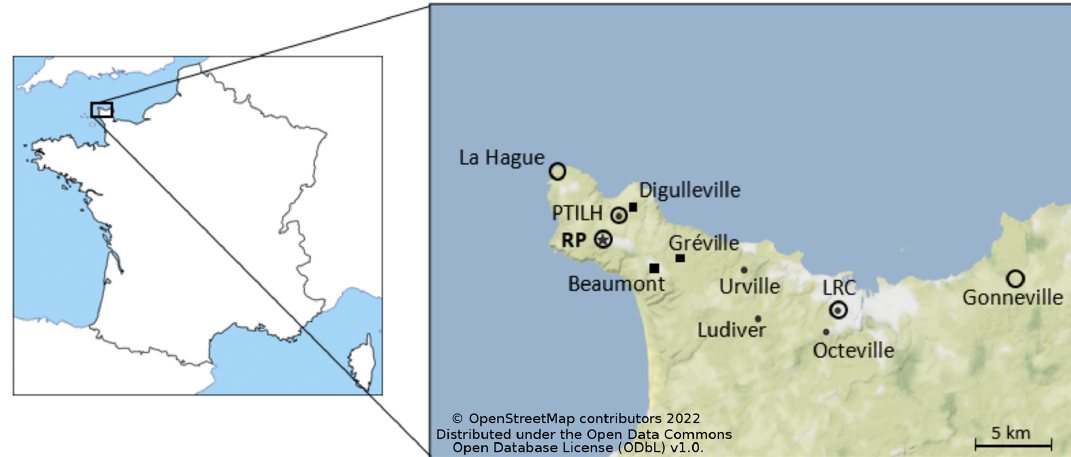
Figure 1. Location of North-Cotentin peninsula (left panel) and map of the monitoring sites (right panel). The dots and squares indicate the locations of the 85 Kr measurement stations carried out by IRSN and RP, respectively, as part of the DISKRYNOC campaign. The RP facility location is marked with a star. The circles indicate the locations of the 3D-wind measurement sites (from IRSN or Météo-France).